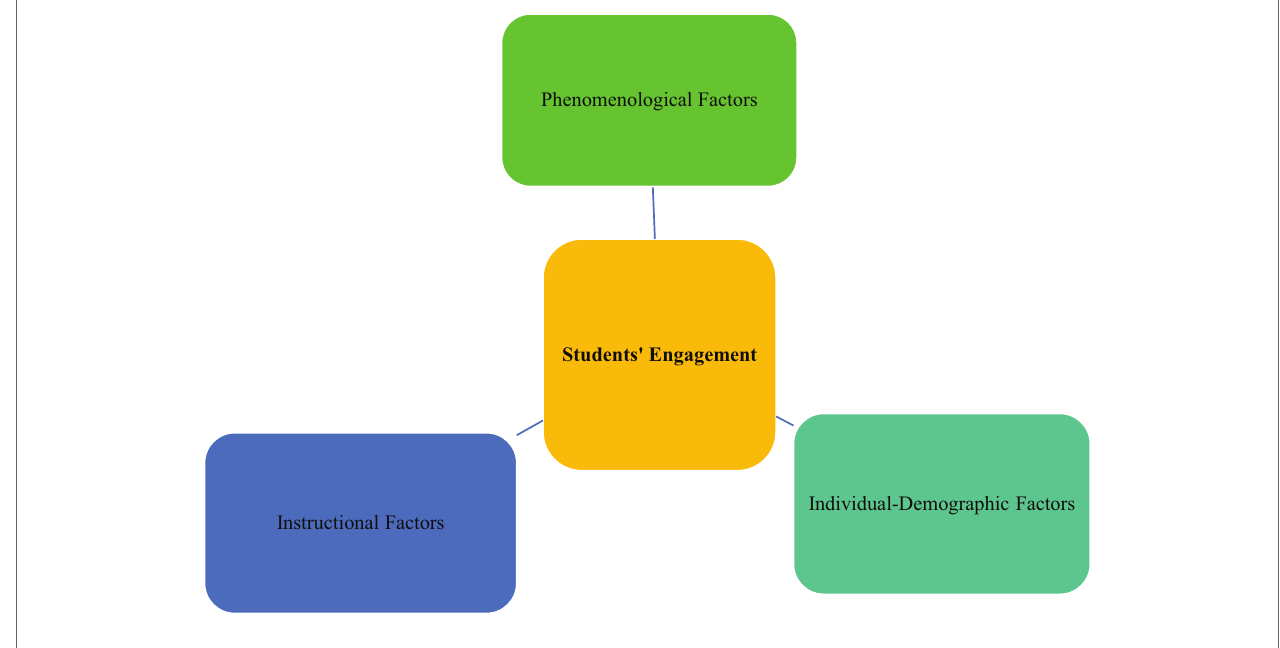
FIGURE 1 | Factors influencing students’